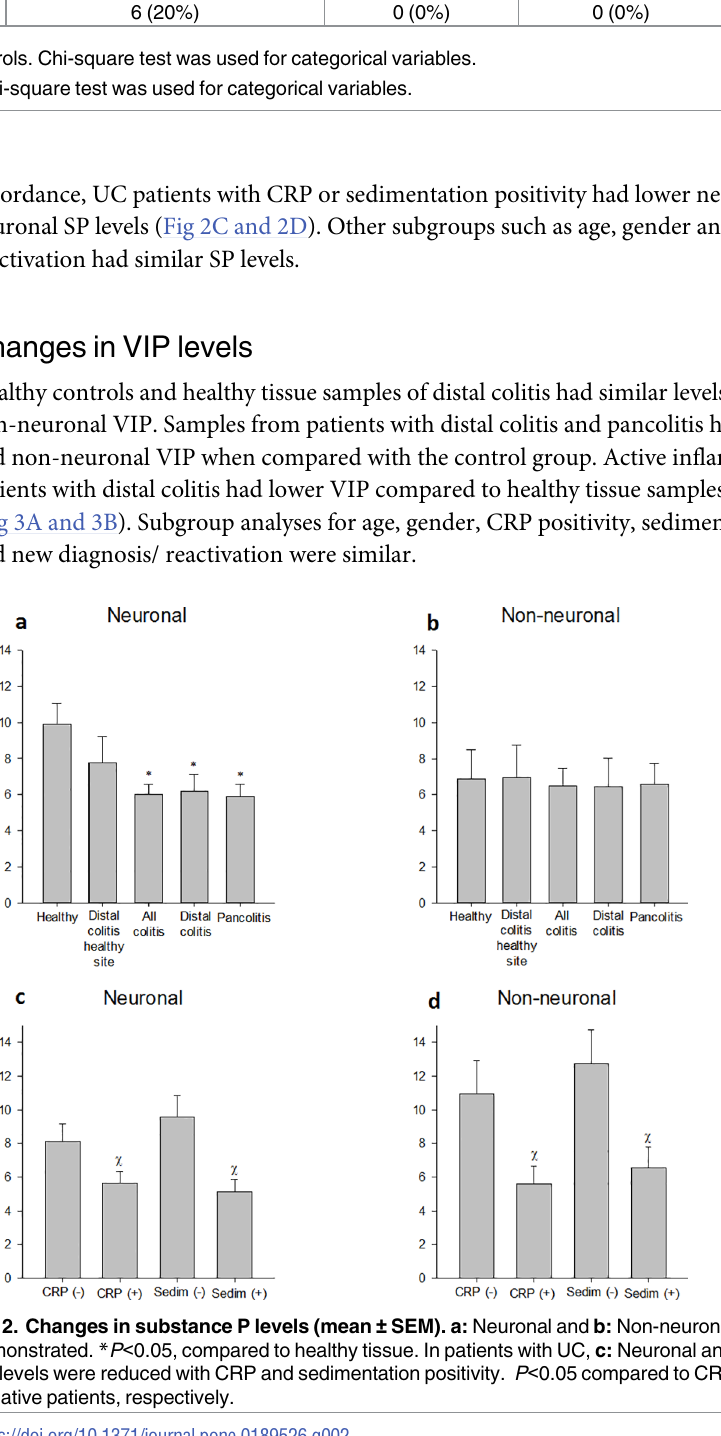
Fig 2. Changes in substance P levels (mean ± SEM). a: Neuronal and b: Non-neuronalSP levels were demonstrated. * P < 0.05,compared to healthy tissue. In patients with UC, c: Neuronal and d: Non-neuronal SP levels were reducedwith CRP and sedimentation positivity. P < 0.05compared to CRP and sedimentation negativepatients,